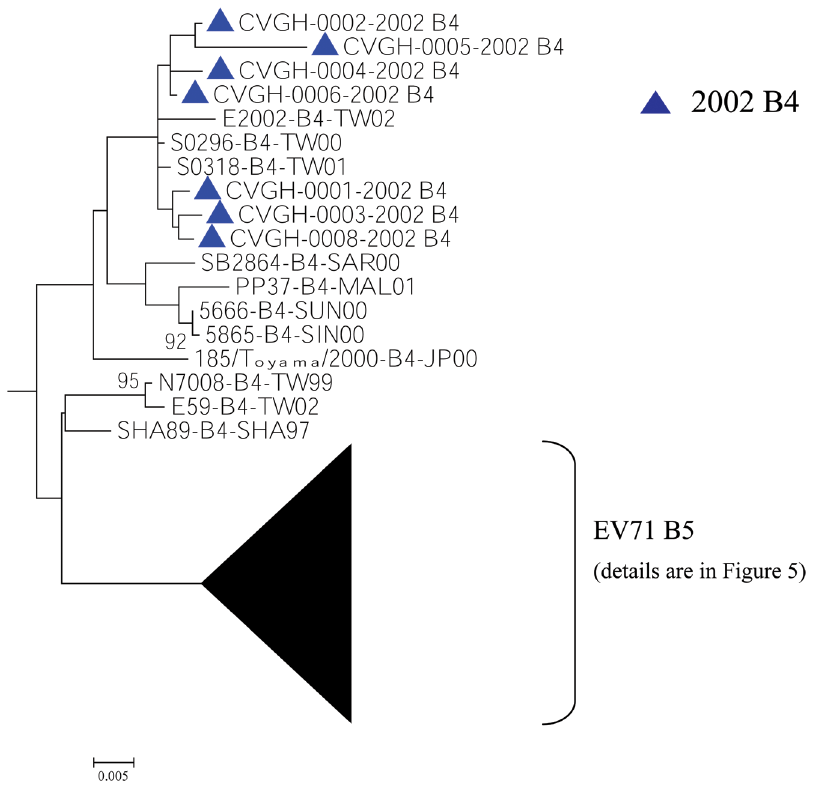
Figure 3. Phylogenetic tree analysis of different Taiwanese and Asian EV71 isolates using Maximum likelihood method with nucleotide sequences from VP1 region (890 nucleotides in length, the subtype B4 clade). Bootstrap analysis was performed using 1000